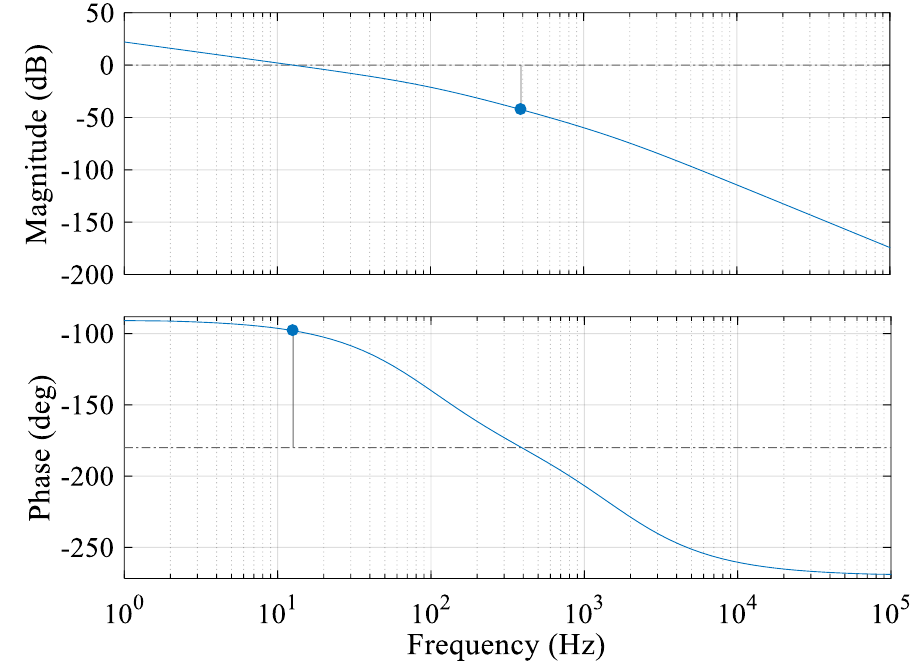
Figure 5. Bode plot of the transfer function of the fundamental voltage control